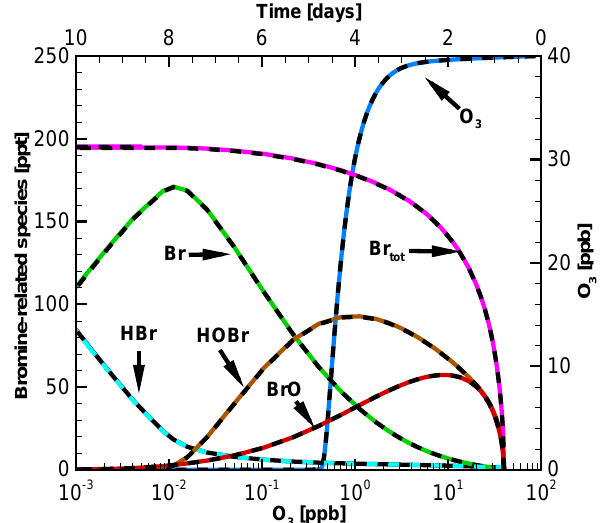
Figure 4. Change of ozone and principal bromine-containing com- pounds plotted with an ozone coordinate axis and a time coordi- nate axis. The solid curves denote the simulation results obtained by using the original reaction mechanism, and the dashed curves represent the results for the reduced reaction mechanism, which is obtained after the concentration sensitivity analysis. The curves of ozone mixing ratios use the axis of time while the principal bromine species correspond to the ozone coordinate axis. Note that the axis of time is in a reverse direction for